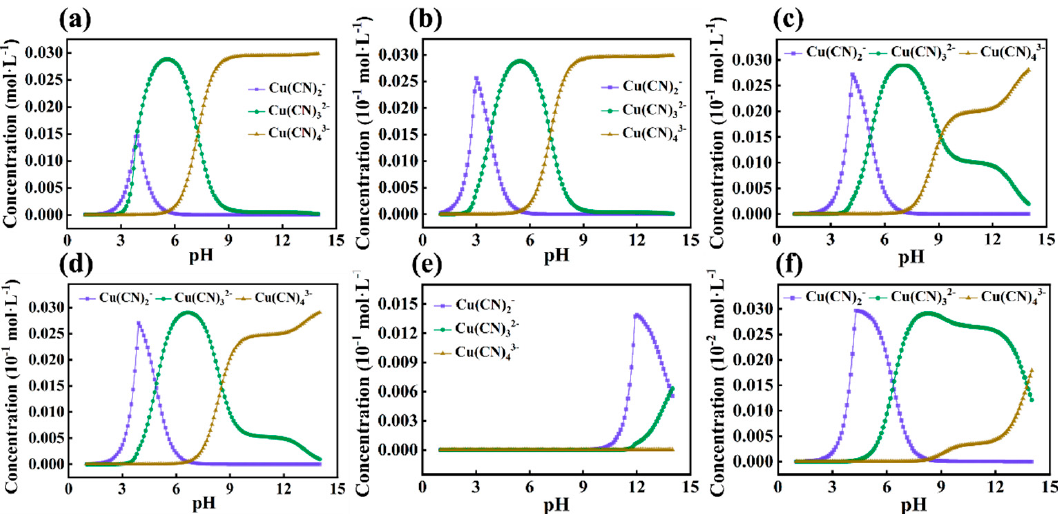
Figure 5. The OLI studio 11.0 was utilized to simulate the distribution of Cu(CN) 2 − , Cu(CN) 32 − and Cu(CN) 43 − as a function of pH under six different concentration gradients, with the following concentrations: ( a ) c(Cu):c(CN) = 0.03:0.3, ( b ) c(Cu):c(CN) = 0.003:0.3, ( c ) c(Cu):c(CN) = 0.003:0.06, ( d ) c(Cu):c(CN) = 0.003:0.03, ( e ) c(Cu):c(CN) = 0.003:0.003, ( f ) c(Cu):c(CN) = 0.0003:0.003.